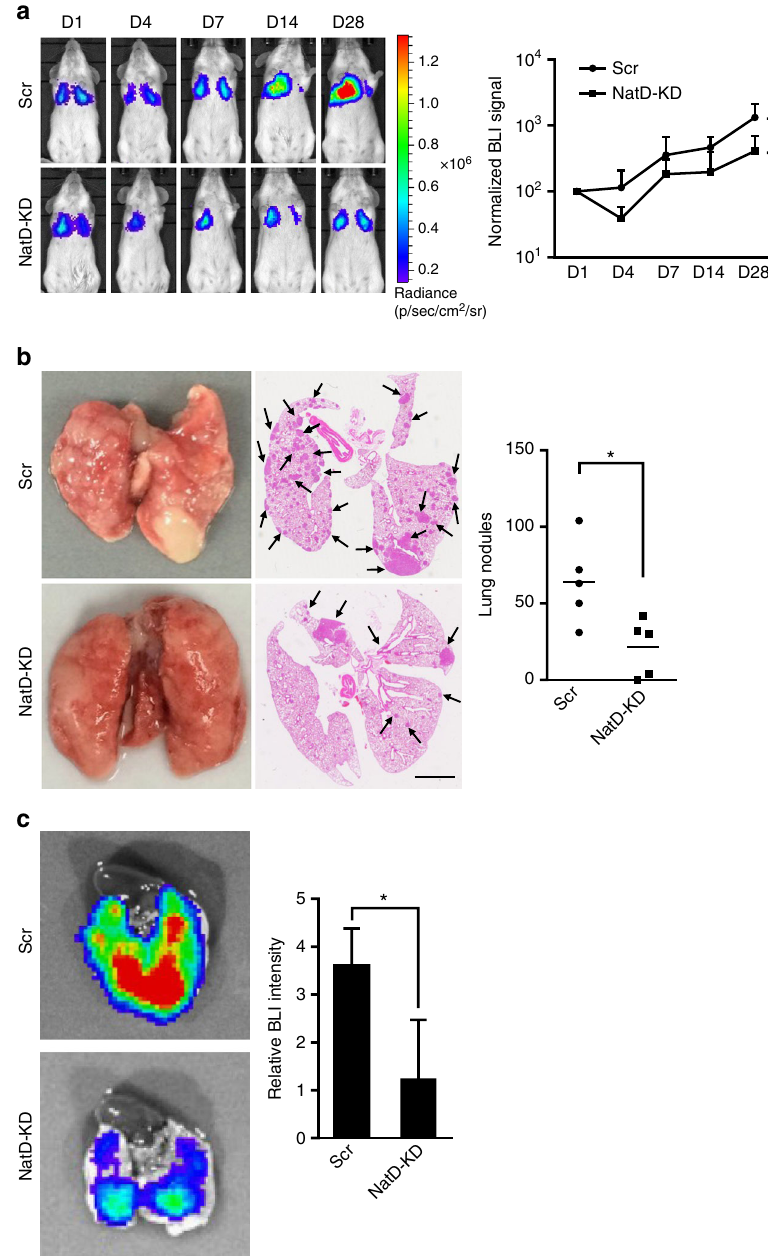
EMT. Loss of component molecules of cell adhesion and tight junctions is the hallmark of EMT in cancer 25, 26 . We then examined changes in expression levels of key EMT-related tran- scription factors and markers in lung cancer cells after NatD knockdown under basal conditions in the absence of TGF- β